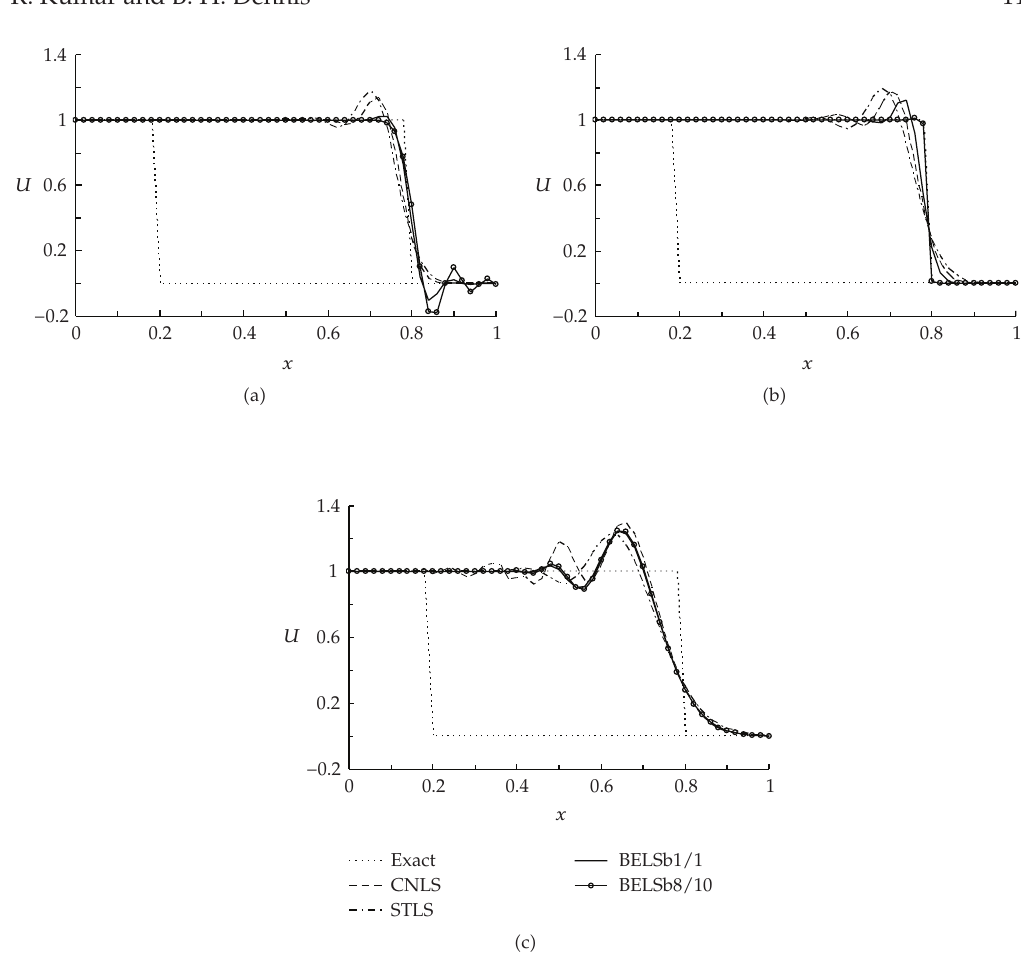
Figure 3: Propagation of a steep front by time t (cid:9) 0 . 6 for Courant numbers, C (cid:9) 0 . 75 (cid:3) a (cid:4) , C (cid:9) 1 . 0 (cid:3) b (cid:4) , and C (cid:9) 2 . 0 (cid:3) c (cid:4) for continuous